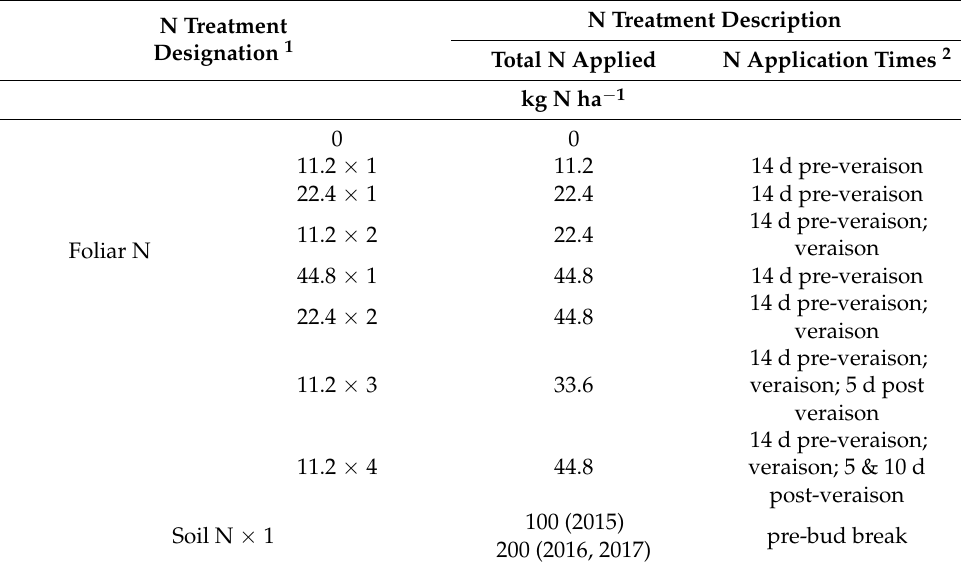
(Table 8). For the soil N treatment, 100 kg N ha − 1 as urea was broadcast applied in early March, prior to budbreak. In subsequent years (2016–17) soil applied N was increased to 200 kg N ha − 1 , while foliar N treatments deviated slightly due to salt damage to foliage observed in 2015 with the 44.8 kg N ha − 1 rate applied once or in two split applications. Table 8. Foliar and soil N treatments used in the 2015–17 field